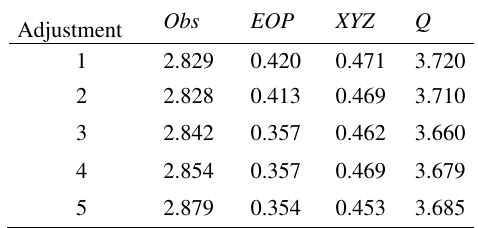
Table 1.Geometric calibration quality estimators obtained for the Leica HDS 3000 with distinct parameterization: 1) All APs; Figure 2. Laser scanner stations and orientations of the zero lines inside the calibration room: a) Leica HDS3000; b) FARO LS 880.